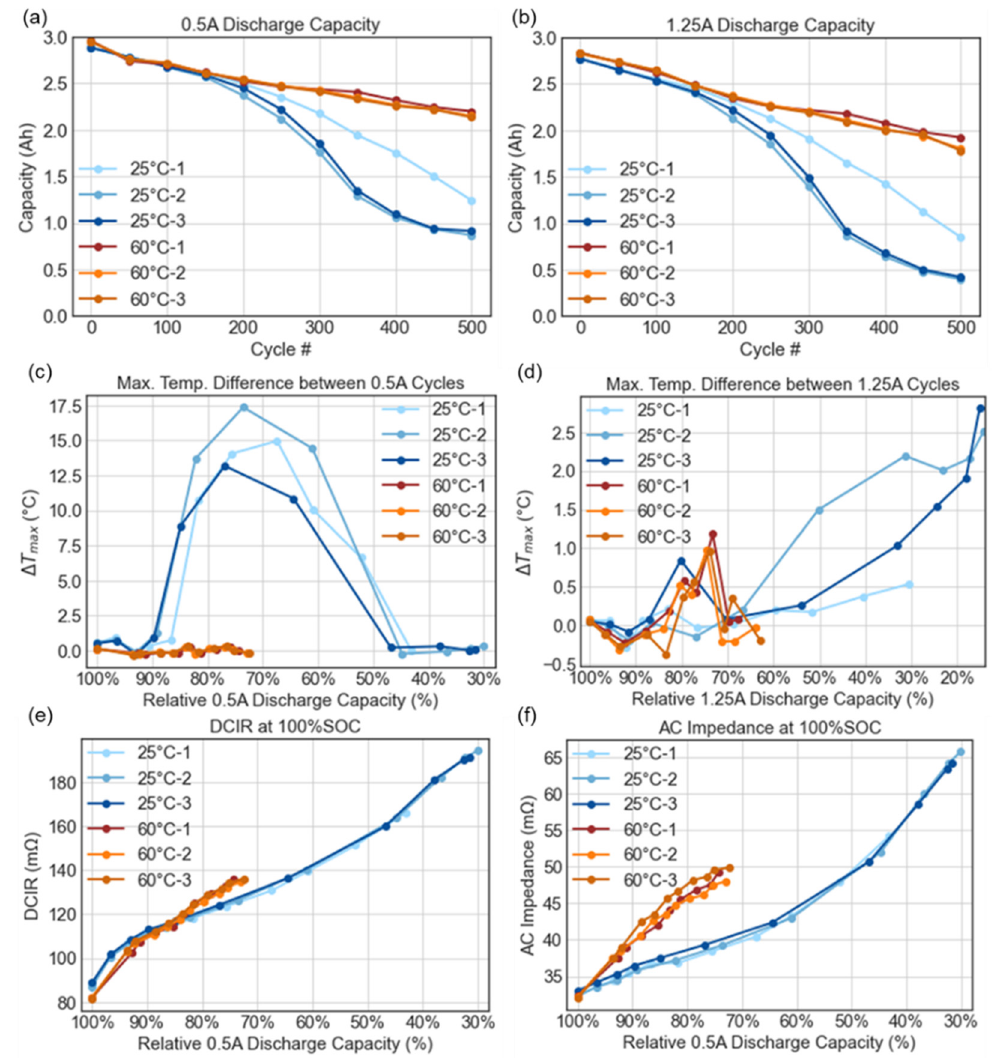
Figure 8. ( a , b ) The discharge capacities in the first 0.5 A and first 1.25 A cycles in the characterization cycles at room-temperature, respectively, after every 50 aging cycles. ( c , d ) Δ T max between two consecutive 0.5 A and 1.25 A charges, plotted against the relative discharge capacity of the first cycle. ( e , f ) DCIR and AC impedance measured at the end of the second 0.5 A charge, plotted against the remaining relative discharge capacity of the first 0.5 A cycle.